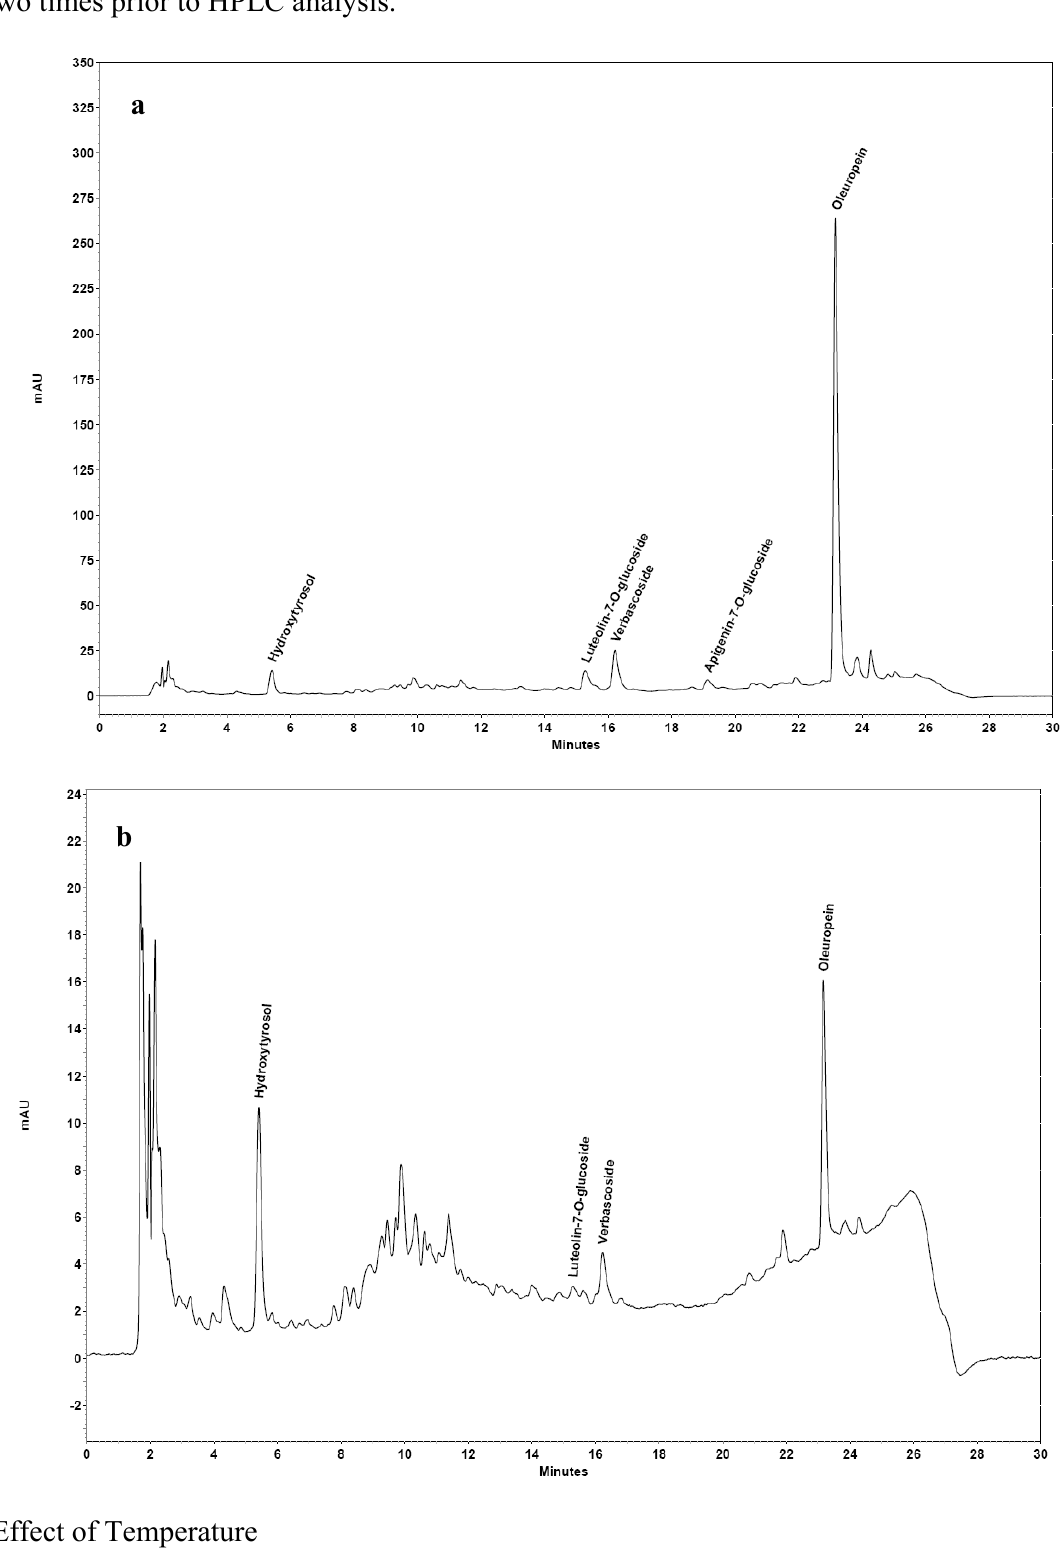
Figure 4. Chromatographic profile at 280 nm of the initial olive leaf extract ( a ) and the water phase (V ) after single-stage salting-out-assisted CPE ( b ). The samples were diluted w two times prior to HPLC